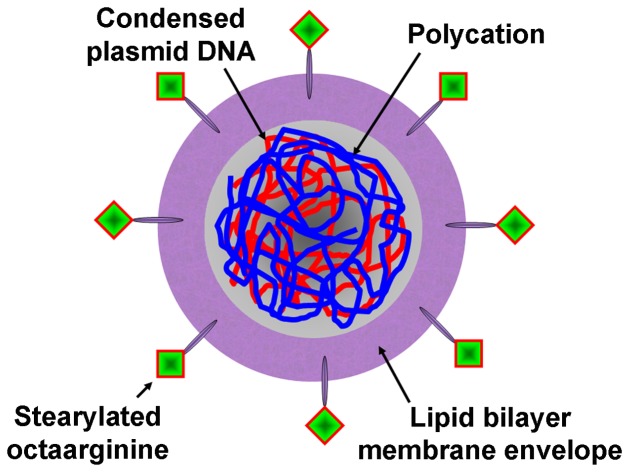
Schematic representation of a D-MEND.It consists of a condensed DNA/polycation core and a lipid bilayer membrane envelope. Its surface is further modified with the membrane penetrating peptide stearylated octaarginine to improve cellular uptake and intracellular trafficking.